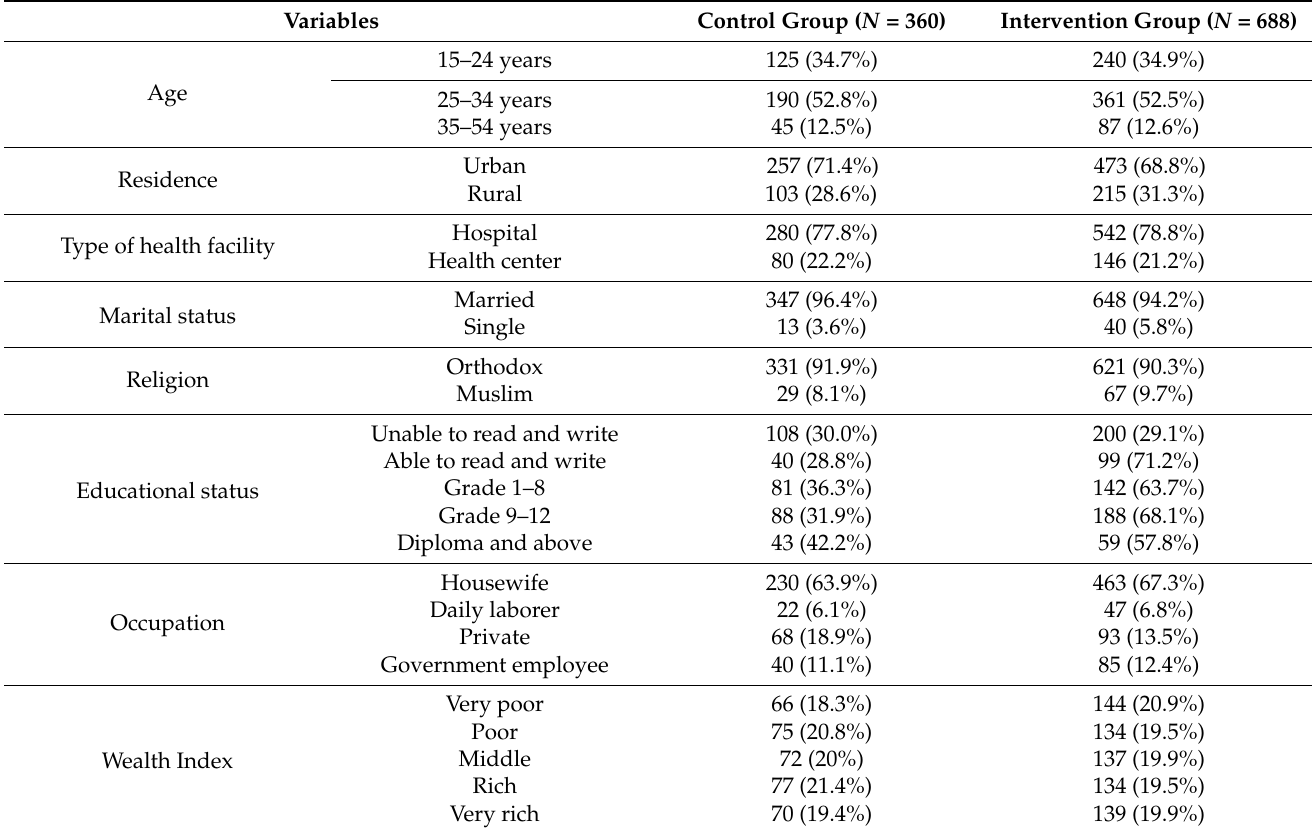
Table 1. Comparison of the socio-demographic and economic characteristics of the study participants between the intervention and control group in Amhara public Health facilities, 2019.